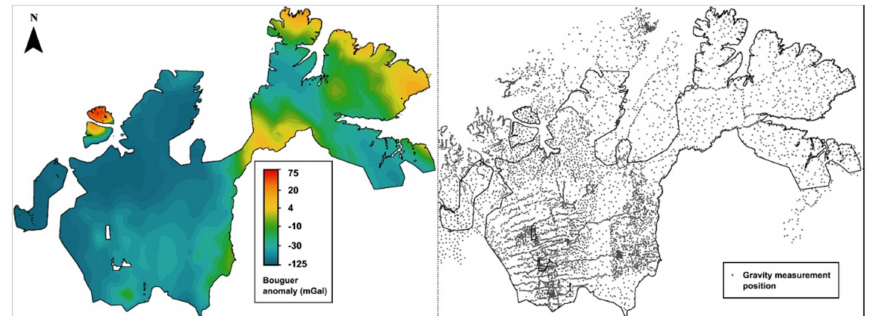
Figure 4. Bouguer anomaly map of the study area (left) based on measurements from gravity stations (right). The magnitude-per-unit area from point was calculated using the Kernel Density method. Mean distance between measurement positions is 1.5